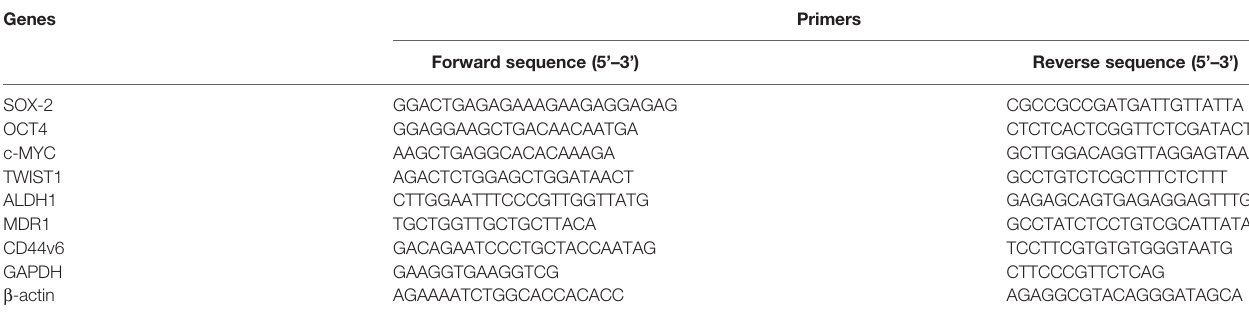
TABLE 5 | Real-time PCR (QPCR) primers for various genes associated with CICs stemness